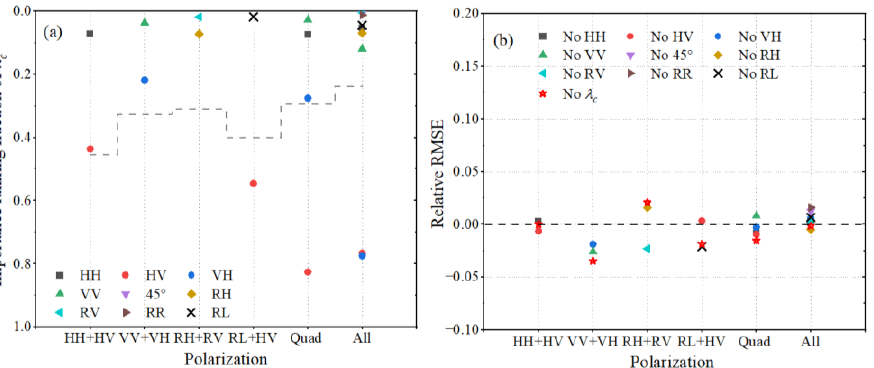
Figure 21. The importance of λ c /β to SWH retrieval from combined-polarization models. ( a ) The importance ranking of λ c /β provided by XGBoost models, normalized to the range of 0 – 1. ( b ) The effect of removing λ c /β on the SWH estimation from different polarized models. The red pentagrams represent the relative RMSE corresponding to the removal of λ c /β -terms in the combined-polarization models.